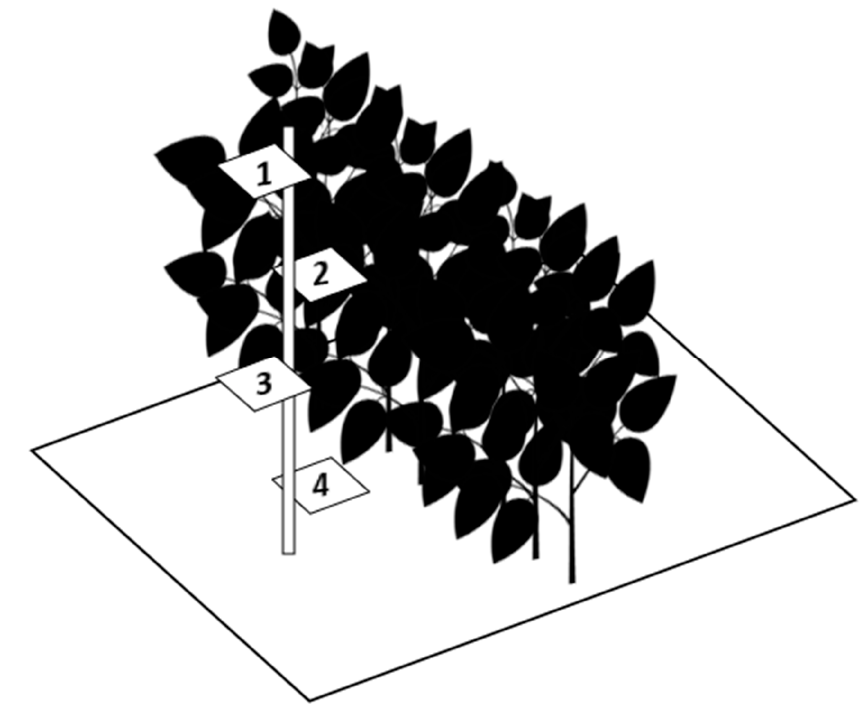
Figure 1. Spray canopy deposition study diagram. Mylar cards were positioned on top canopy – 61 cm